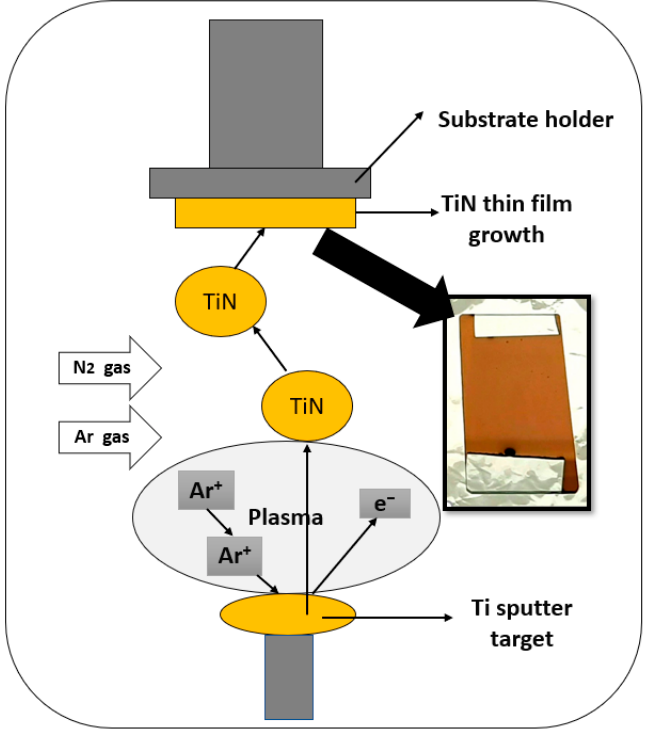
Figure 1. Schematic diagram of radio frequency (RF) Magnetron sputtering system used to prepare the TiN thin-film layers. Insert showing the image of the deposited TiN film on the glass sub- strate.